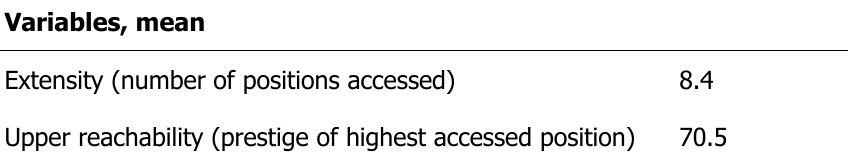
Table A1. Summary of position-generated indexes and position generator in the